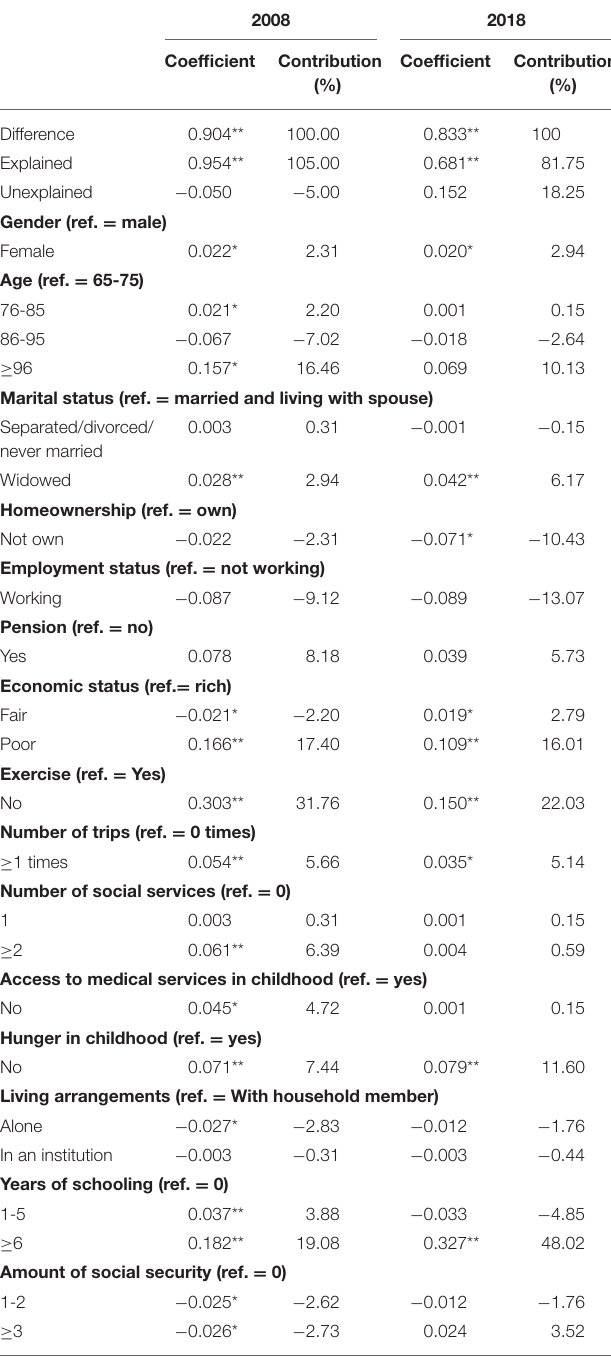
TABLE 2 | O-B decomposition of the urban-rural disparity in cognitive performance in 2008 and 2018.